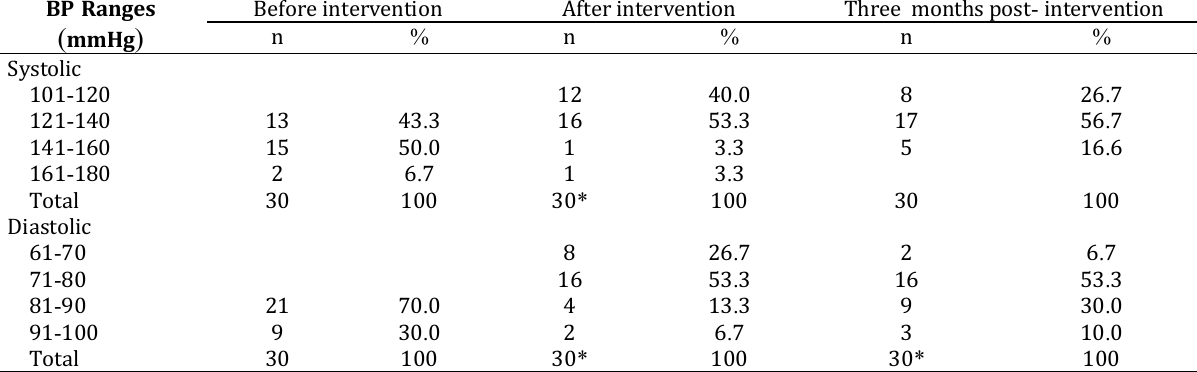
Table 3. Amount and Percentage of Blood Pressure among People with Uncontrolled HT Before, After Intervention, And Three Months Post-